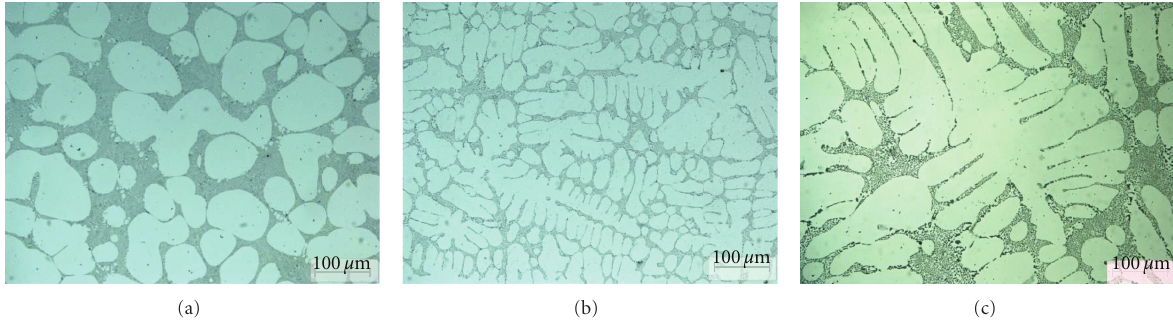
Figure 2: Optical micrographs of A356 in the as-cast condition produced by (a) SSM-HPDC, (b) GDC, and (c) IC.